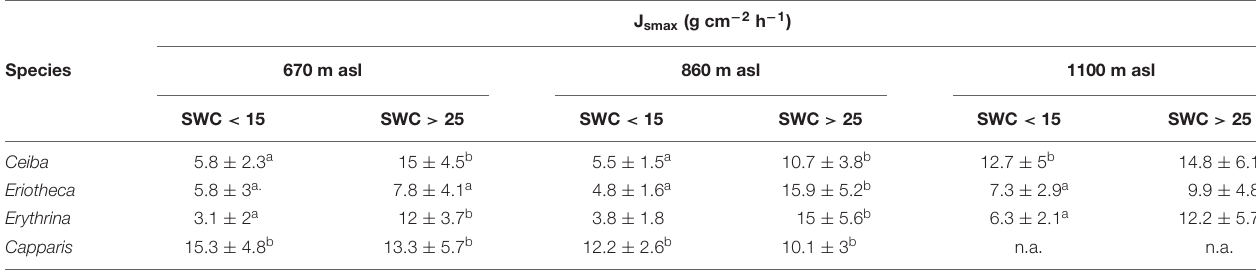
TABLE 3 | Maximum sap flux densities under dry and wet soil conditions.